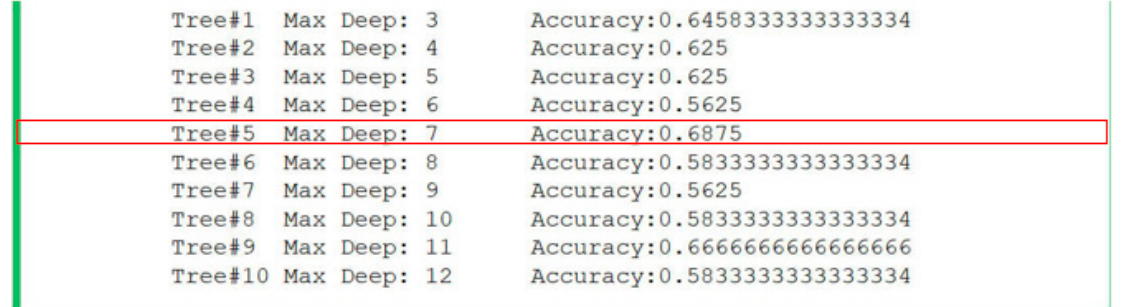
Figure 5. Calculated accuracy of decision trees created for different maximum depths from a dataset created according to Approach 1.